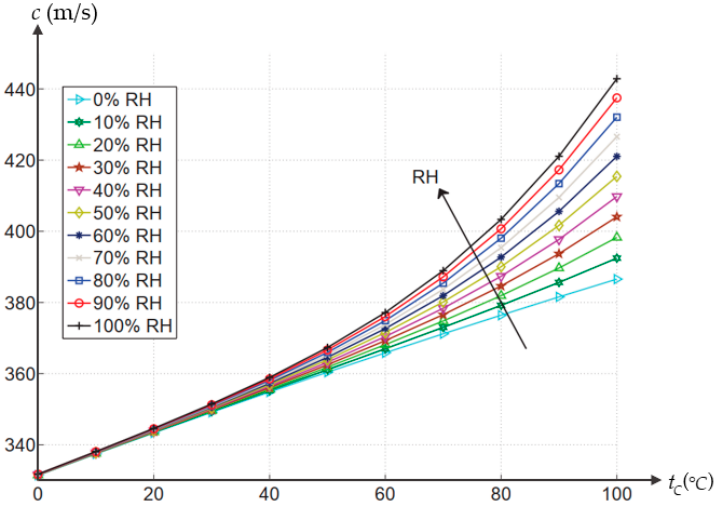
Figure 25. Variation of the speed of sound to temperature and relative humidity [162].